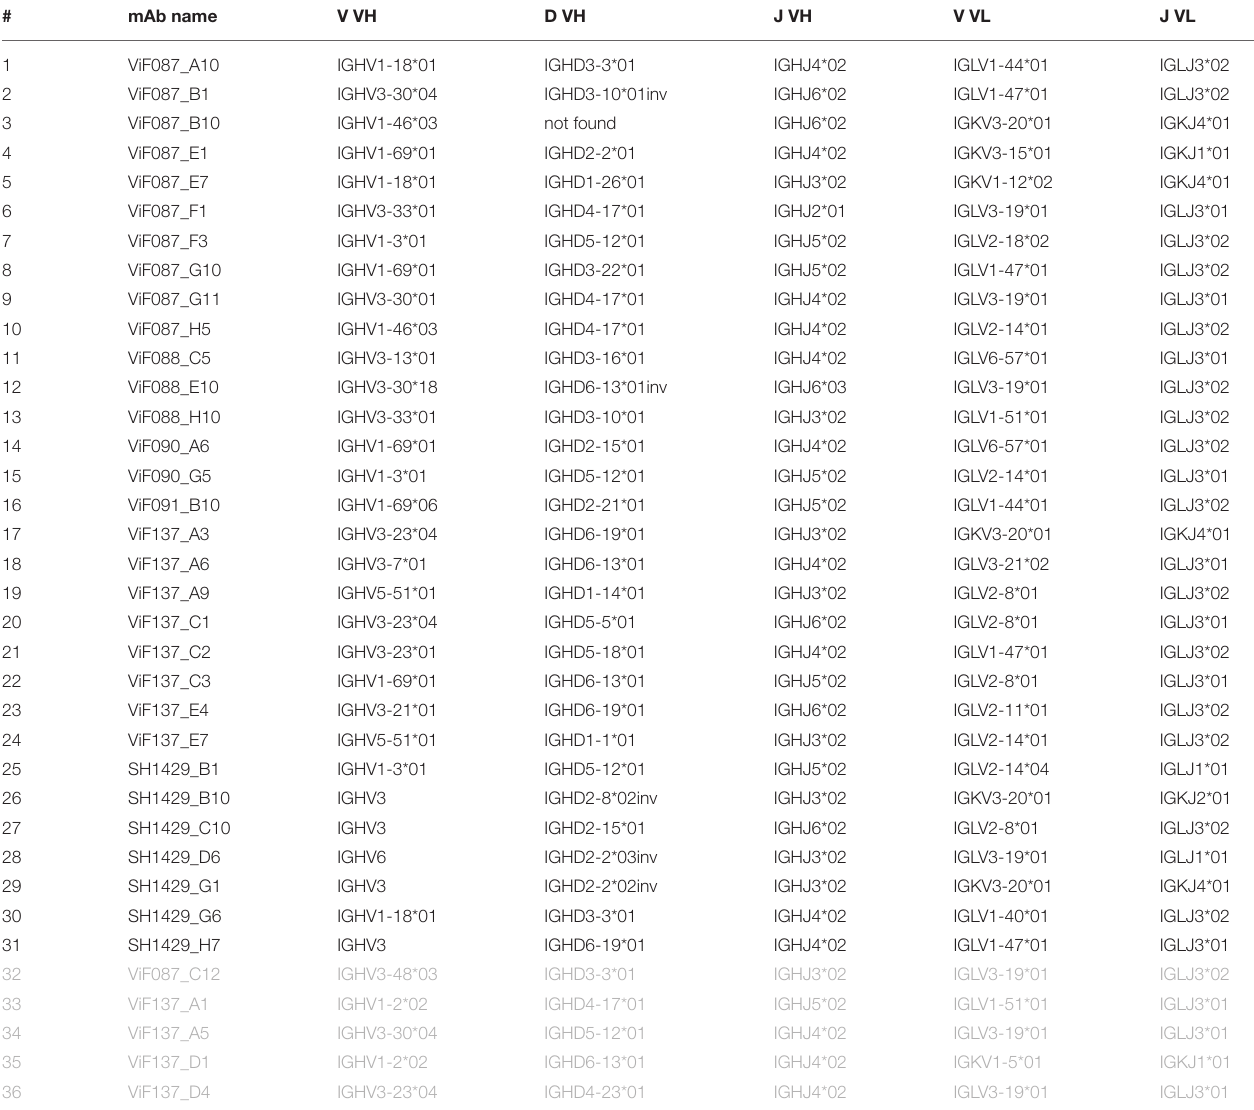
TABLE 2 | Overview over gene families of generated